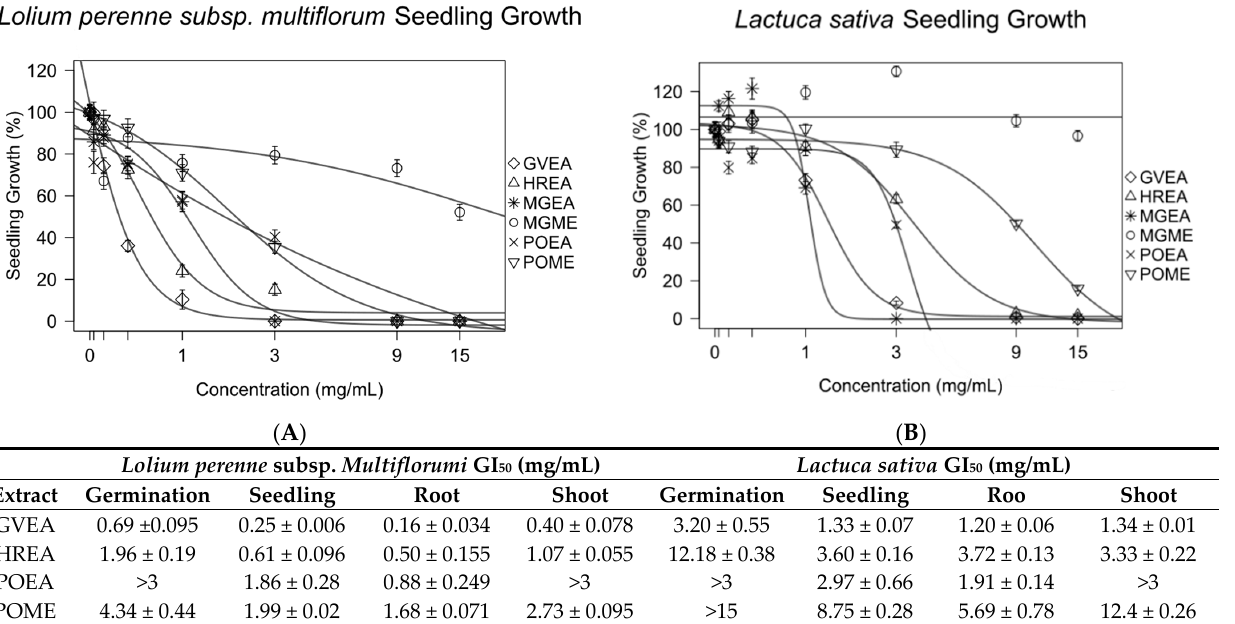
shoot lengths (Figure 4B). The inhibition was centered around row 13, with a broad band potentially indicating diffusion. Row 13 was separated, analyzed, and found to consist of a single compound. This compound was purified and recrystallized from a mixture of methanol:chloroform by the slow evaporation method, and its structure was established to be onoseriolide ( 4 ) by X-ray crystallography (Figure 5).